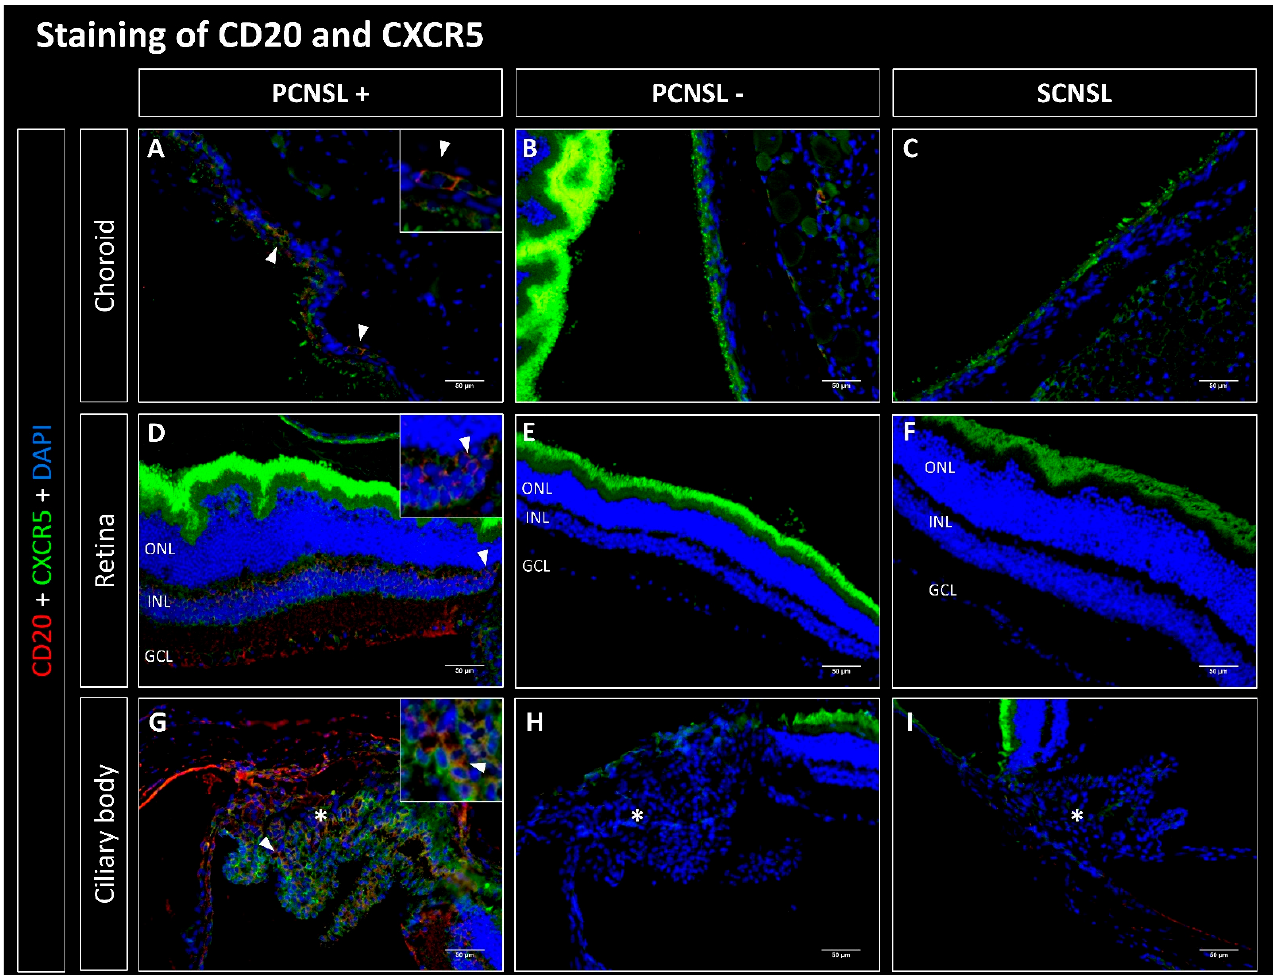
Figure 2. Fluorescence microscopy of CD20 (red) and CXCR5 (green) double staining of the eyes in the PDX PCNSL vs. PDX SCNSL group. ( A – C ) show recordings of the choroid, ( D – F ) of the retina and ( G – I ) of the ciliary body (marked with *). ( A , D , G ) show the choroid, retina, and ciliary body infiltrated with CD20-positive primary CNS lymphoma cells (PCNSL+), which additionally